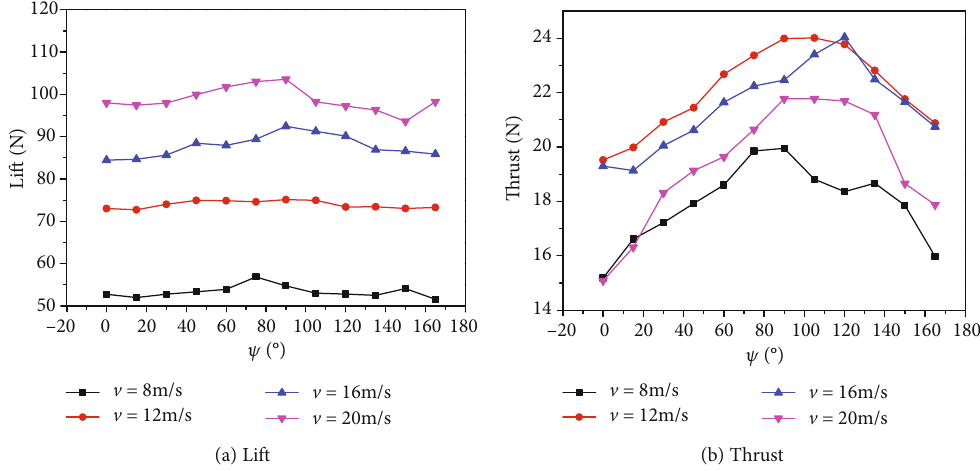
Figure 7: The variation curve of the installation angle of the single leading edge winglet with the fl ow ( α = 0 °